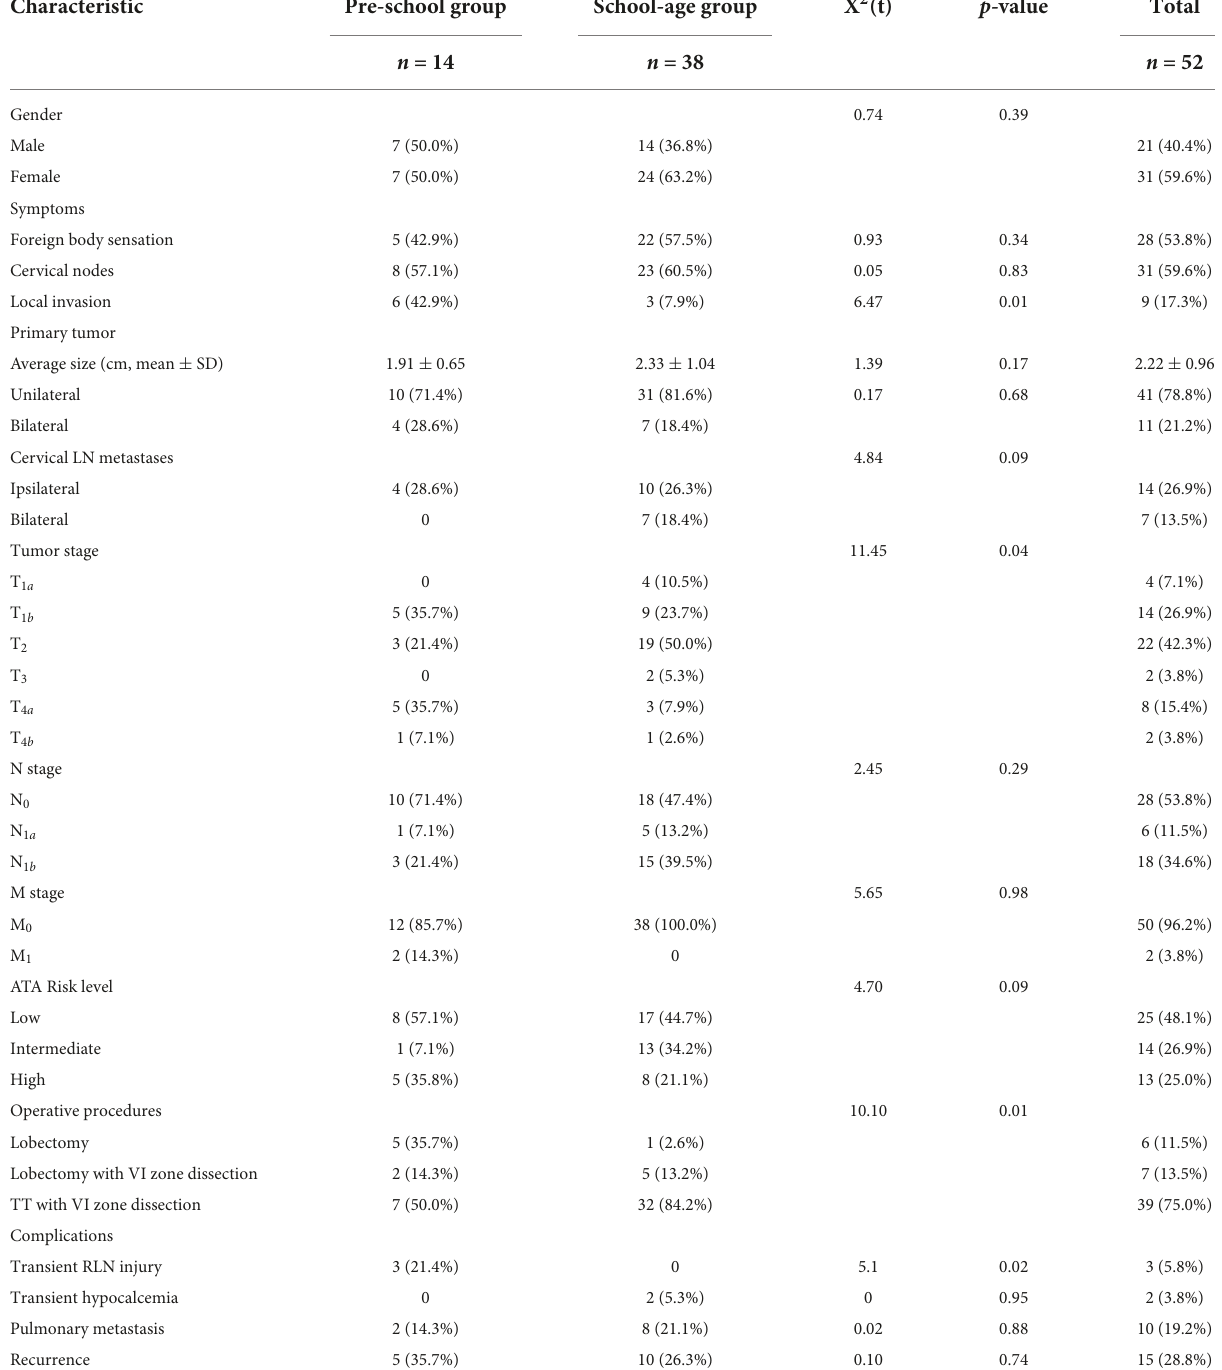
TABLE 2 Analysis of the clinical data of DTC in pre-school and school-age